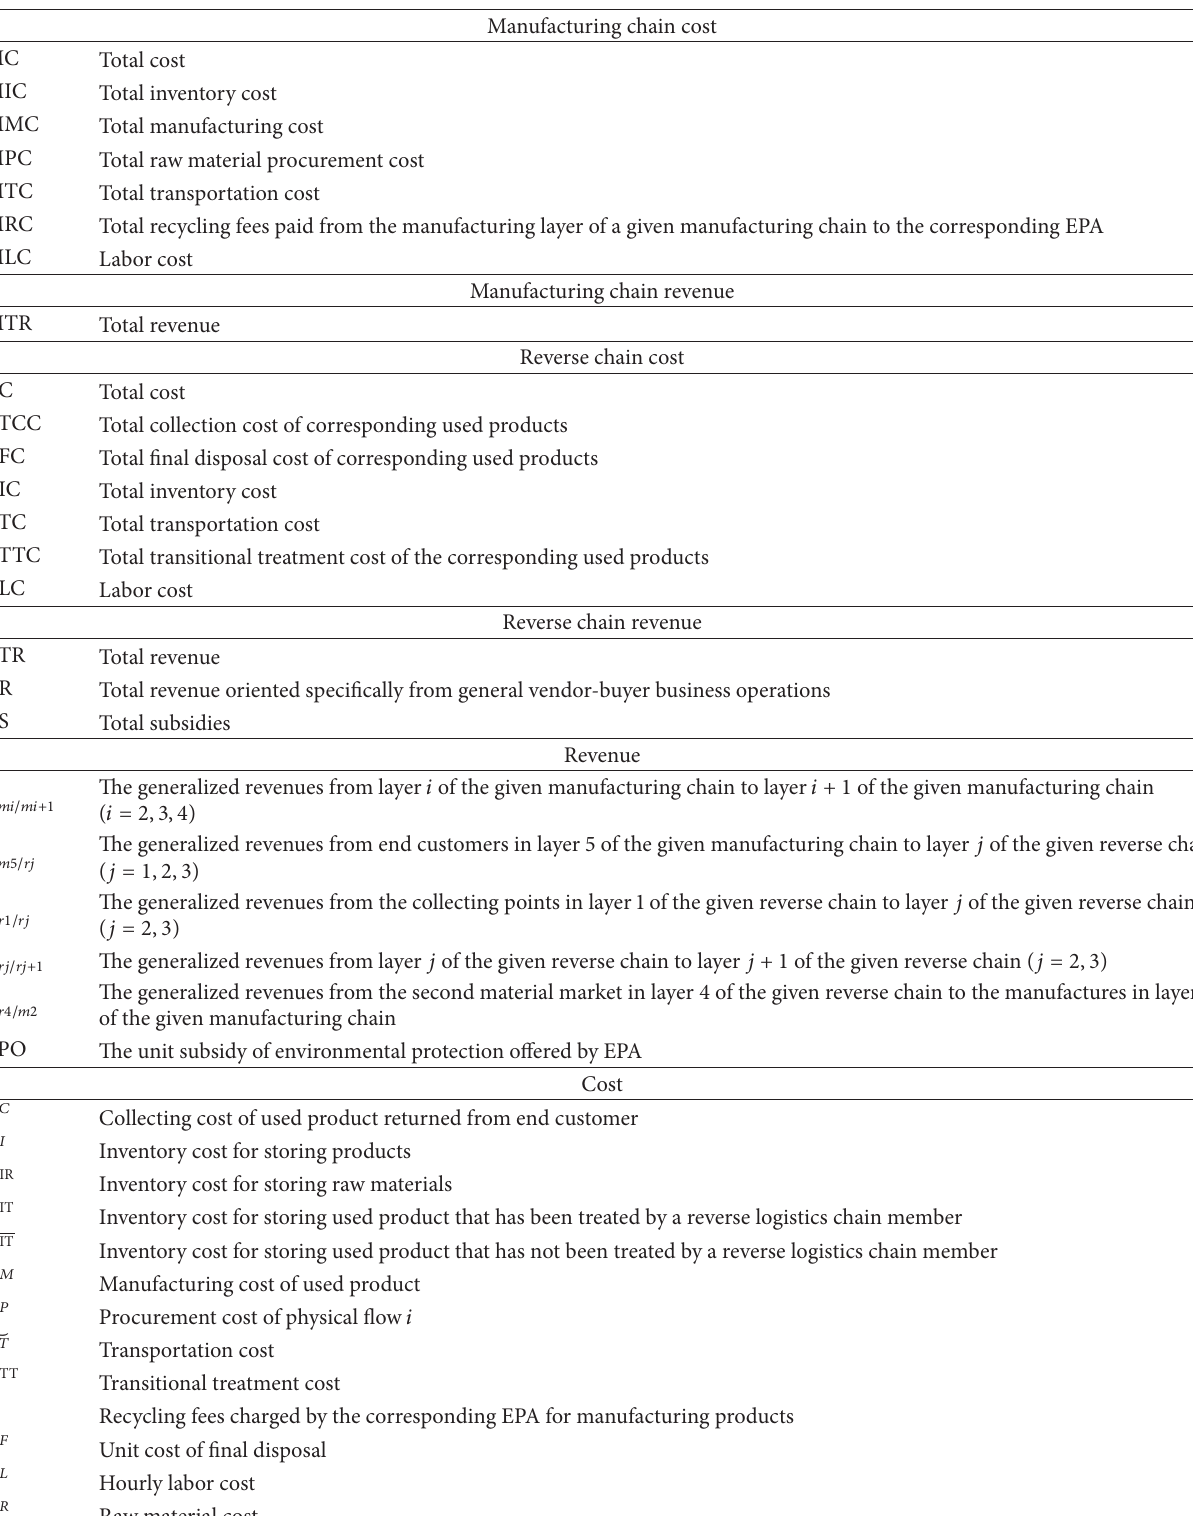
Table 7: Notations for our proposed